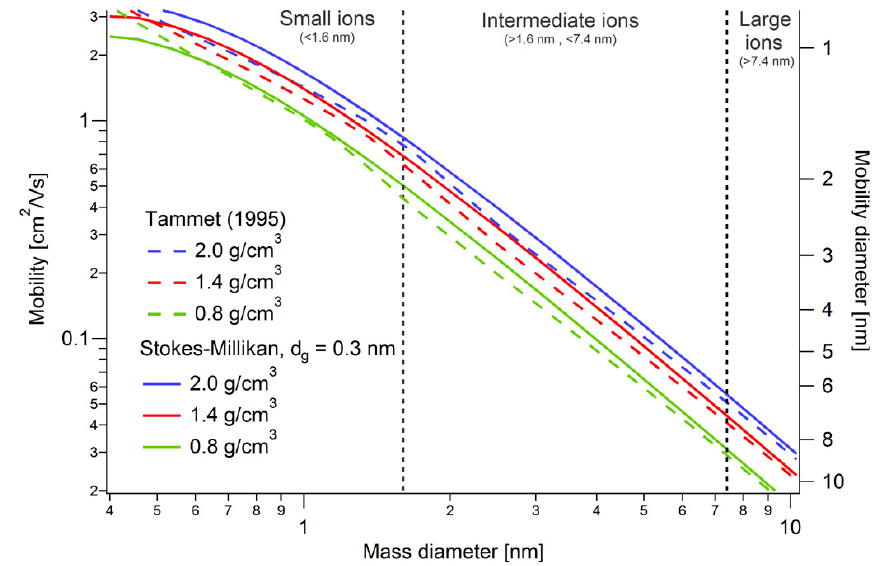
Fig. 1. Mobility versus mass- and mobility diameter calculated according to Tammet (1995) and modified Stokes-Millikan (Ku and de la Mora, 2009) using three different